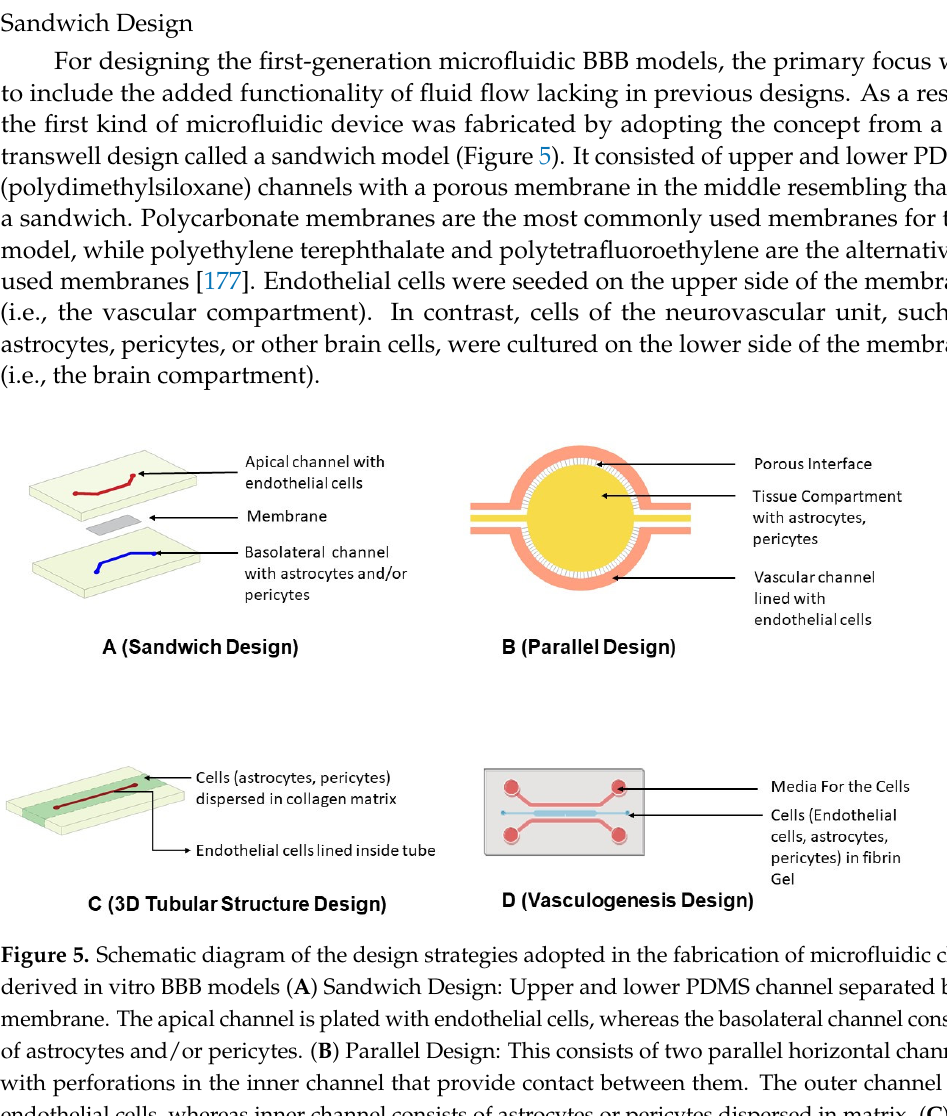
Figure 6. Self-assembled vasculatures of the BBB designed by the vasculogenesis approach. ( A ) The design depicts self-assembled endothelial cell vasculature in conjunction with astrocytes that harbors neuronal cells. The media for vascular channel and neural channel are supplied through side flanks. ( B ) Immunohistochemistry of vascular networks demonstrating astrocytes and vascular channel interface. Astrocytes end feet seen on the neuronal layer is spread at the surface of vascular channel which stops after the interface. (Source: Reprinted from Bang, S.; Lee, S.-R.; Ko, J.; Son, K.; Tahk, D.; Ahn, J.; Im, C.; Jeon, N. L. A low permeability microfluidic blood–brain barrier platform with direct contact between perfusable vascular network and astrocytes. Sci. Rep. 2017 , 7 , 1–10, [181], under an open access Creative Commons CC BY 4.0 license). Hajal et al. [182] generated a BBB model using a vasculogenesis approach where two endothelial cell types (iPSC-derived endothelial cells (iPS-ECs) or primary human brain microvascular endothelial cells (HBMECs)), astrocytes, and pericytes in fibrin gel were